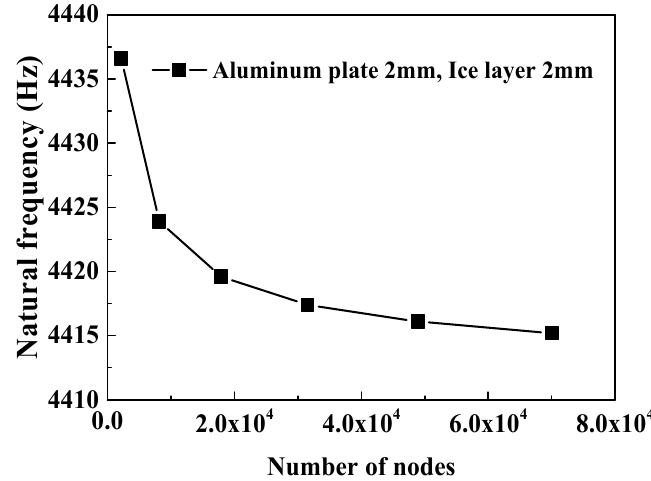
Figure 5. Mesh sensitivity analysis.